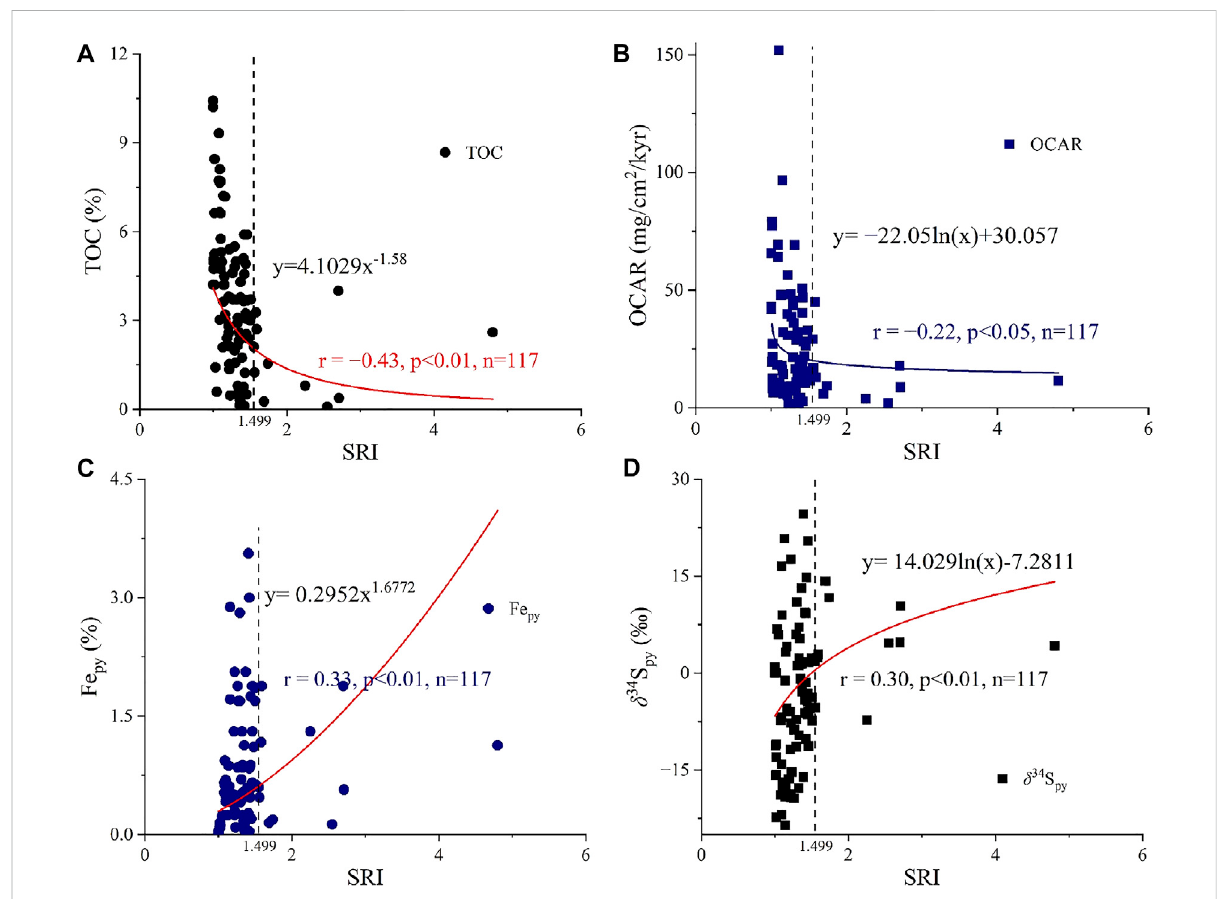
FIGURE 7 Crossplots of SRI vs. (A) TOC, (B) OCAR, (C) Fe py and (D) δ 34 S py